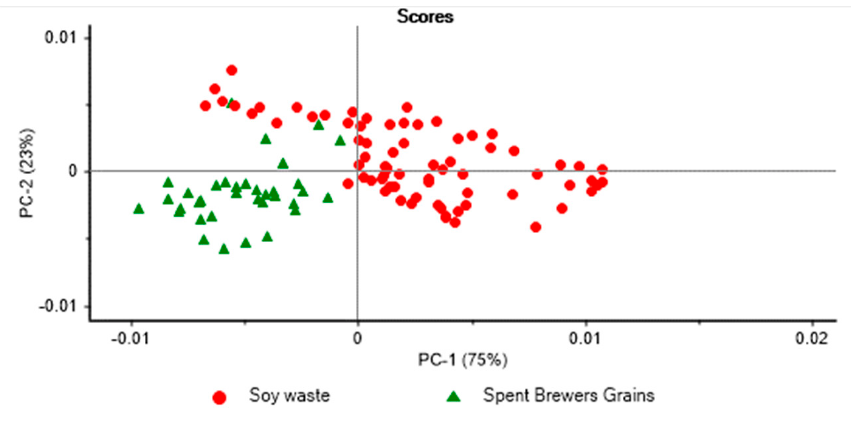
Figure 4. Principal component score plot of 6th instar pre-pupae reared on soy waste and spent brewers’ grains and analysed using near infrared spectroscopy.